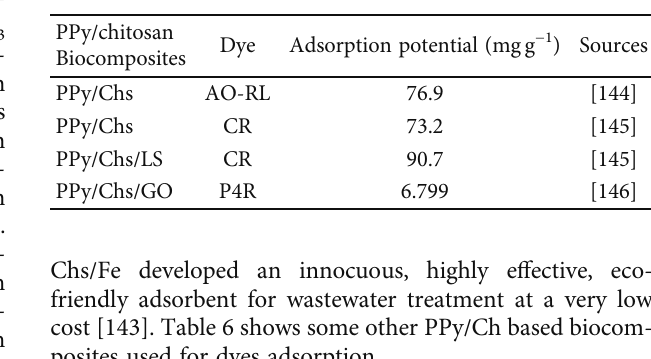
Figure 6: General schematic representation of synthesis of PPy/agrarian waste-based biocomposites. Table 6: List of common PPy-/Chs-based biosorbents used for removal of